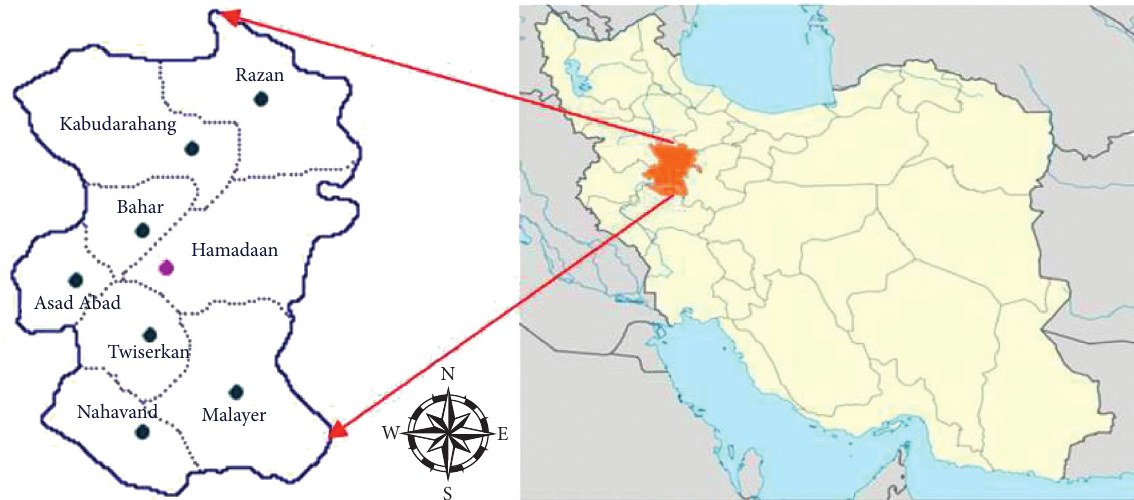
Figure 3: Location map of Hamadan province in the Iran.